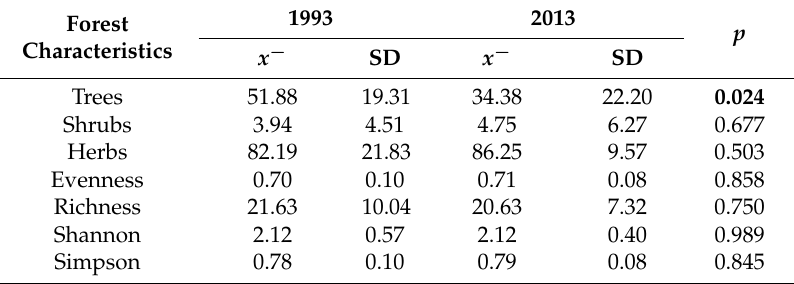
Figure 3. Ellenberg’s moisture, light and temperature passively fitted as surface into ordinal space in NMDS. Table 3. Comparison of vegetation layer covers and diversity measures between surveys in 1993 and